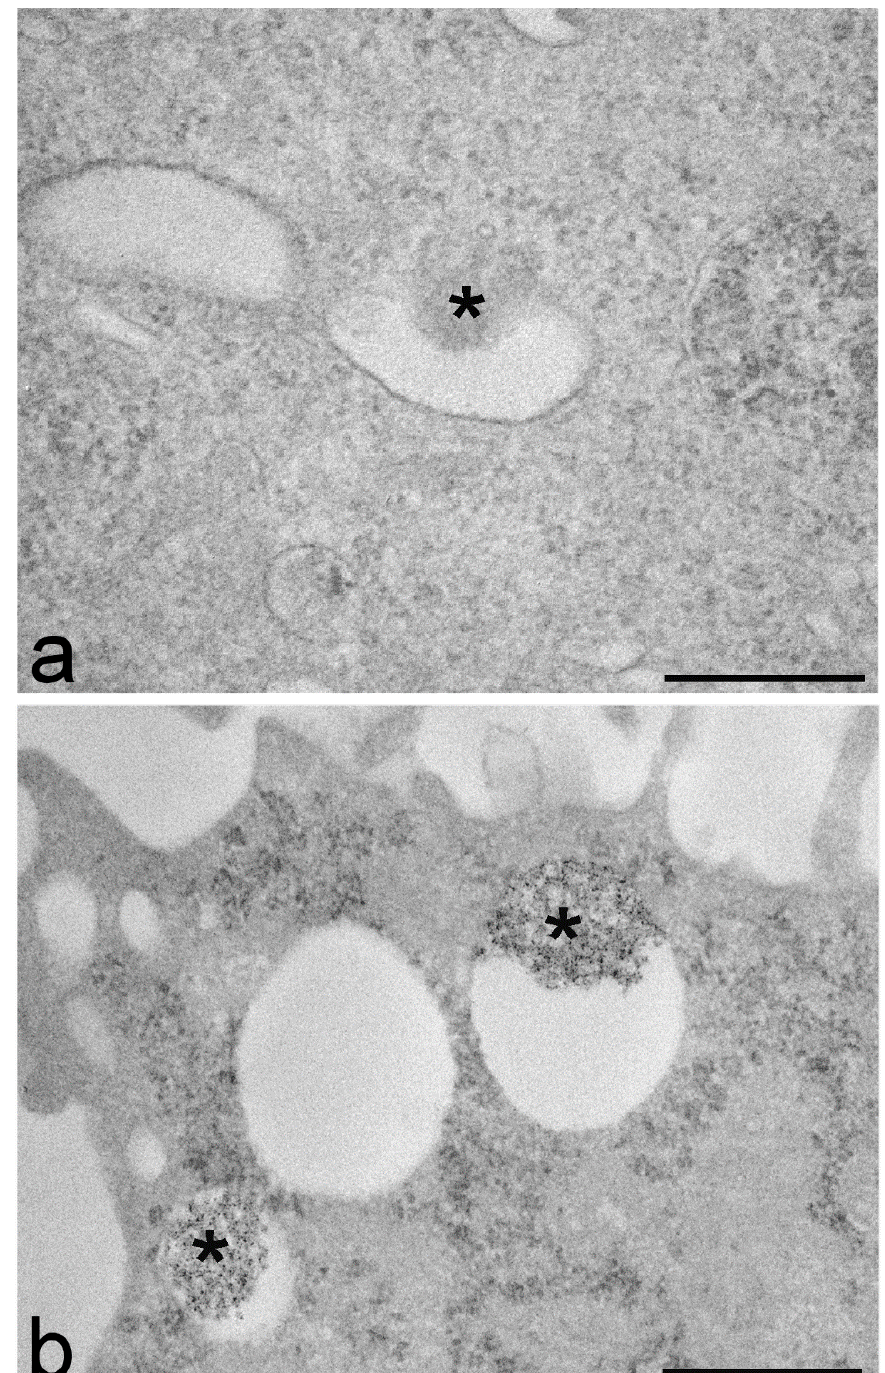
Figure 2. Transmission electron micrographs of B50 cells incubated for 24 h with chitosan-based nanoparticles (asterisks). The sample in ( a ) was fixed with aldehydes, post-fixed with osmium tetroxide and embedded in epoxy resin and the sample in ( b ) was fixed with aldehydes, submitted to DAB photooxidation, post-fixed with osmium tetroxide and embedded in epoxy resin. Both samples were stained with uranyl acetate. In ( a ), the nanoparticle inside the endosome is hardly recognizable due to its weak contrast whereas in ( b ), the electron-dense reaction product of DAB photooxidation makes the nanoparticles clearly visible. Bars: 500 nm. Image in ( b ) from Malatesta et al.